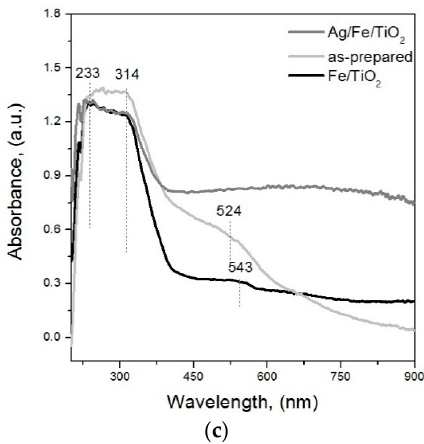
Figure 5. DRS of the supports based on TiO 2 , modified with Ce ( a ), Mg ( b ) or Fe ( c ) oxides and their corresponding catalysts before (as-prepared) and after reduction in H 2 under 300 °C for 1 h.